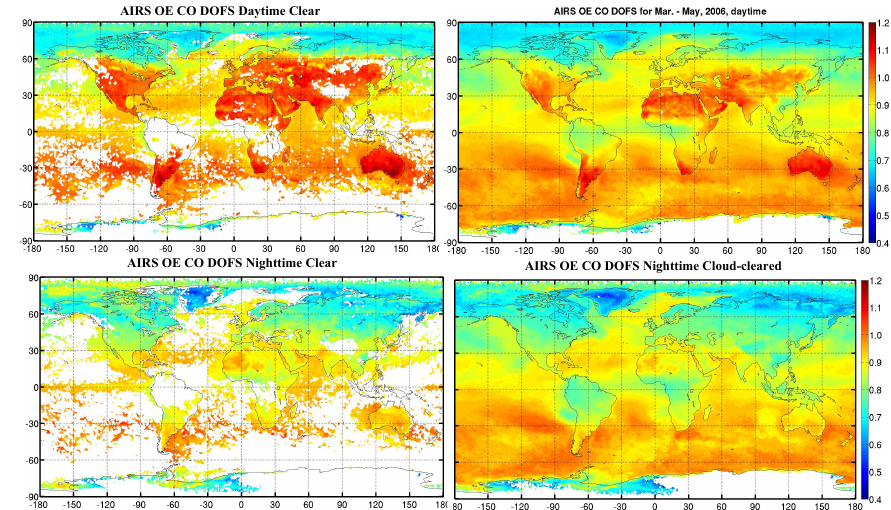
Figure 4. AIRS optimal estimation CO DOFS for the months of March to May 2006 for cloud-cleared cases (right panels) versus clear cases (left panels) and for daytime (upper panels) versus nighttime (lower panels).